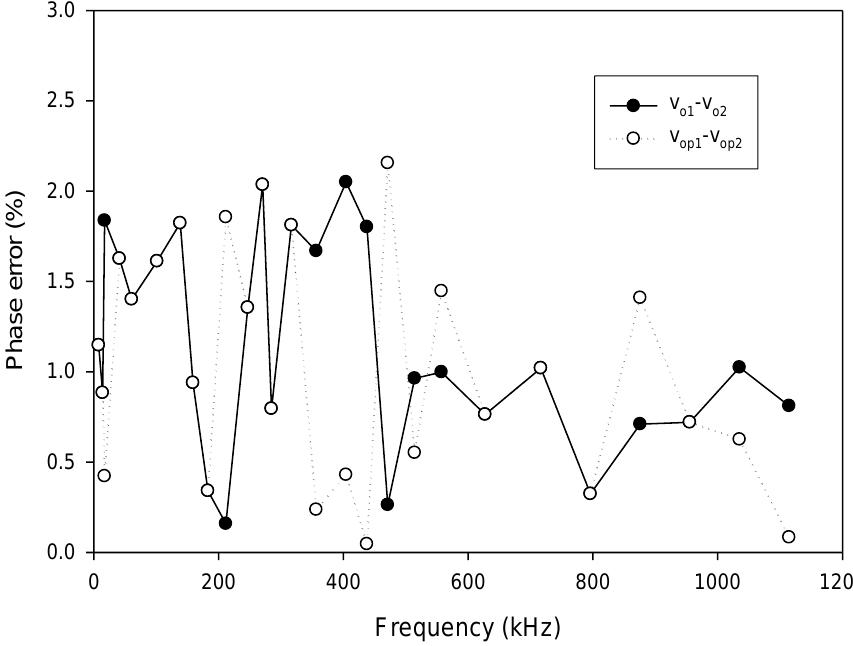
Figure 14. The plot of the phase error vs. frequency of oscillation (FO).